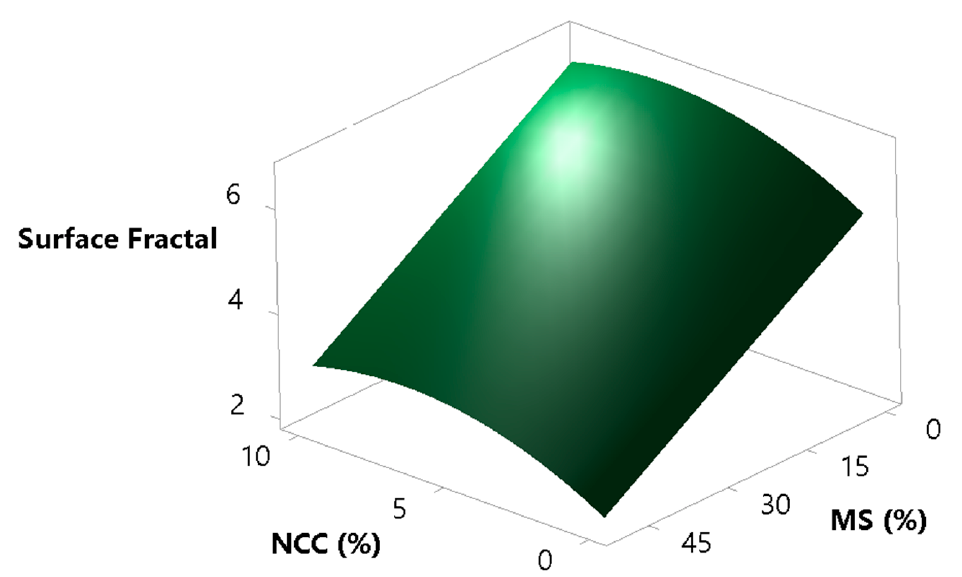
Figure 13. Surface plot showing the effects of the concentrations of MS and NCC on the sample surface fractal.